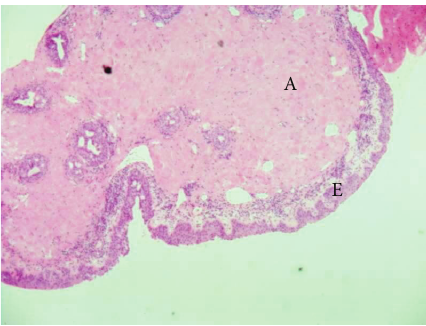
Figure 2: Photomicrograph of the biopsy specimen shows deposit of amyloid in the conjunctival chorion stained in pink (Congo red 50x); E = conjunctival epithelium and A =